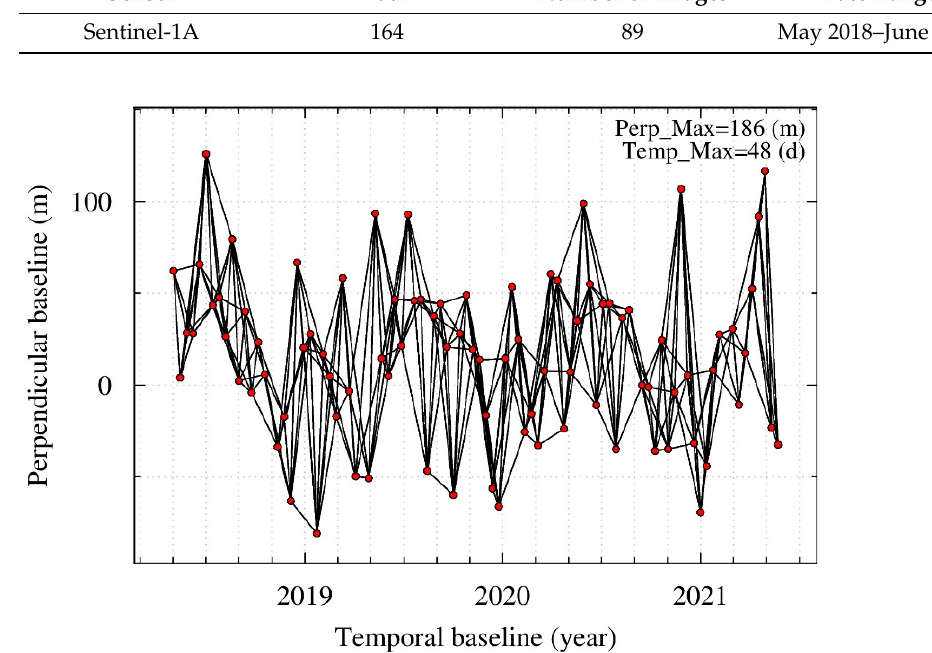
Figure 2. Spatio-temporal baseline of the interfering